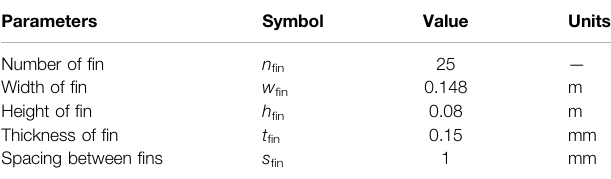
TABLE 2 | Structural parameters of cooling fi ns Parameters